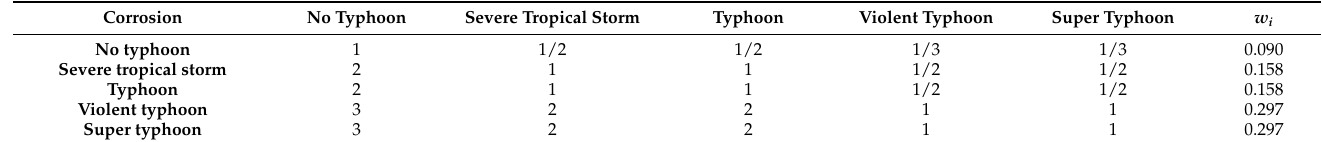
Table 11. Important degree judgment matrix of corrosion under different typhoon intensity.